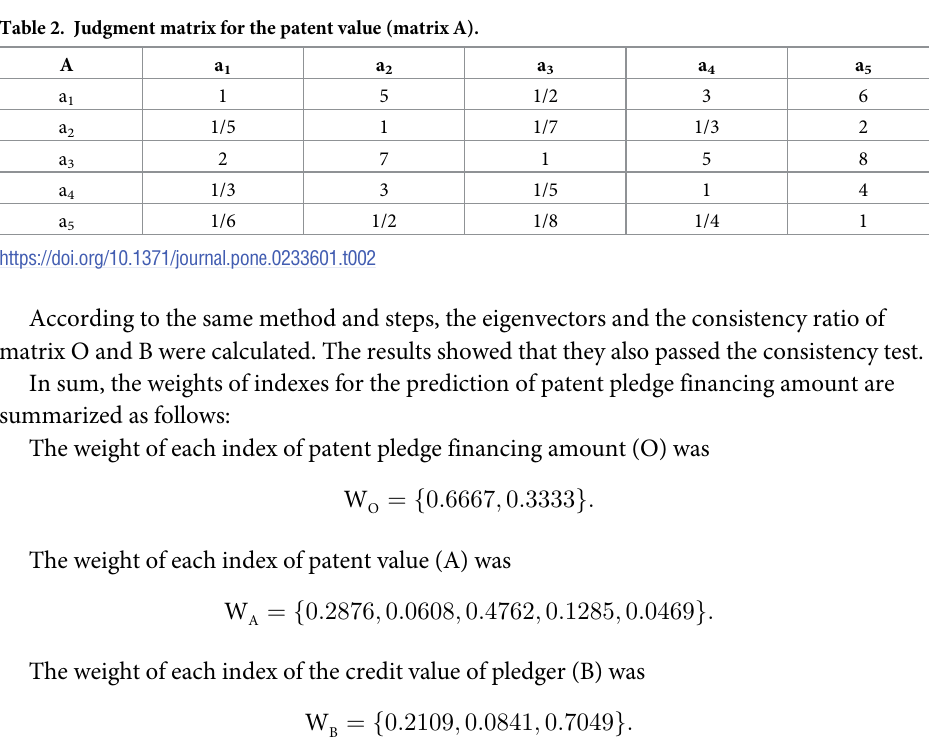
Table 2. Judgment matrix for the patent value (matrix A).